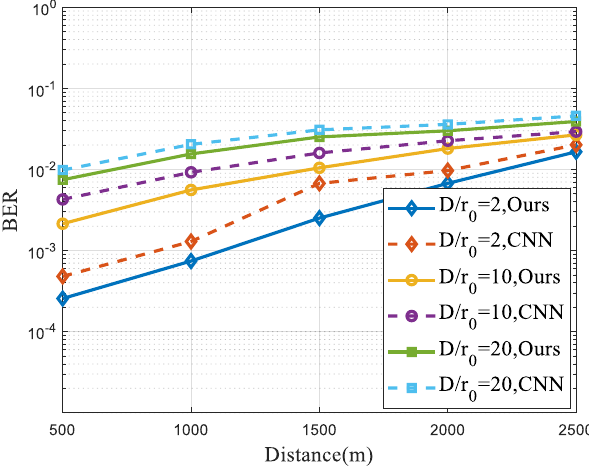
Figure 10. Comparison of system BER at different transmission distances. Table 3. Comparison of accuracy and calculation time of different